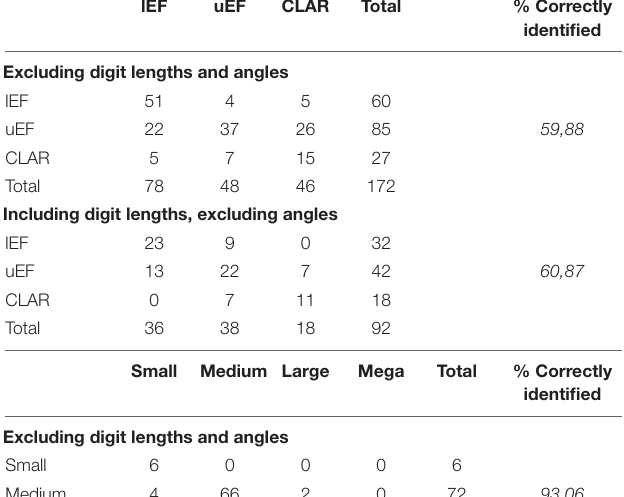
TABLE 4 | Summary of the discriminant analysis confusion matrix. Tracks with TL ≤ 25 cm and 25 < TL < 40 cm have similar apparent trends up stratigraphy: erratic TL/TWs, and lEF uEF CLAR Total % Correctly a decrease in DP/TS, DP/TL and DP/(TL-DP) ( Figures 6A,B ). identified The DP/TL ratios (TL ≤ 25 cm and 25 < TL ≤ 40 cm) and DP/(TL-DP) ratios (TL ≤ 25 cm) for uEF and